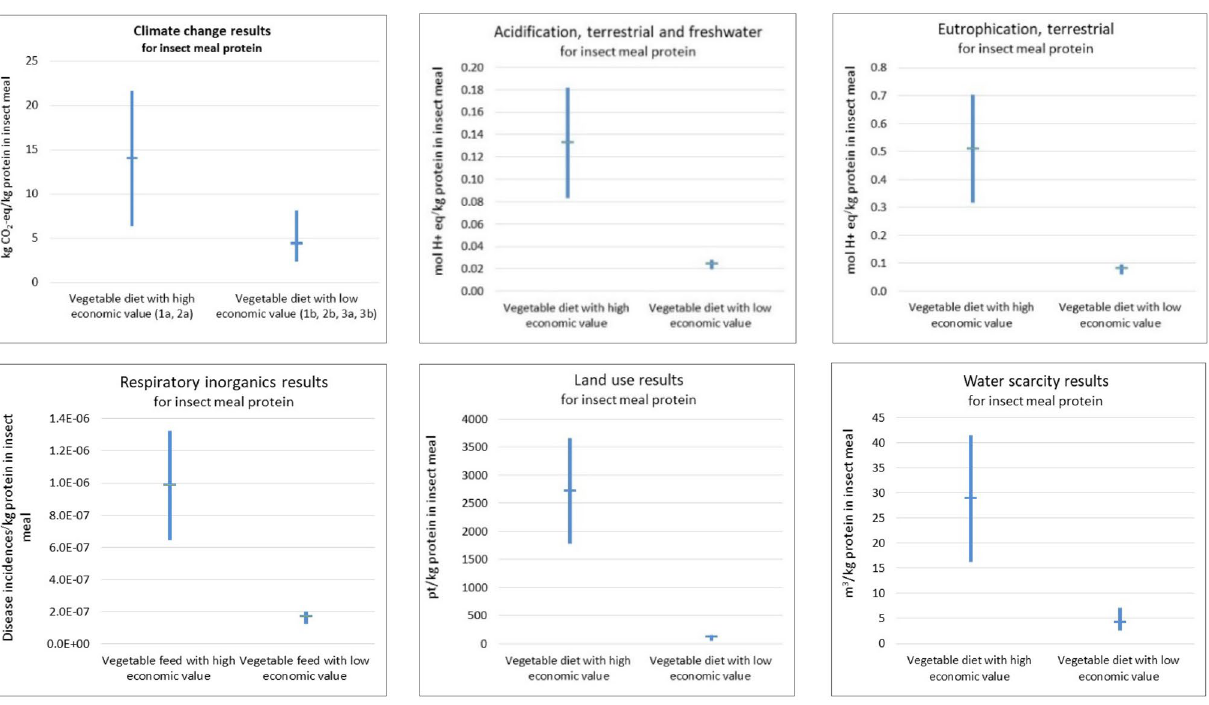
Fig. 5 Results for rearing and processing insects into insect meal, presented for two groups based on insect diet (results given per kg pro- tein delivered to the west coast of Norway). Number of insect cases: 6 in total